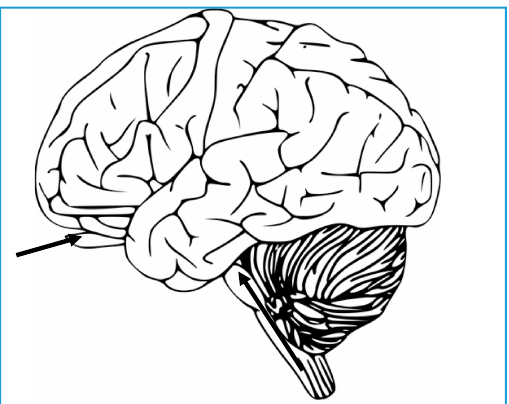
Figure 4. Schematic of brain with arrows depicting origins of the brain pathology—i.e., brain stem and olfactory bulb in Parkinson’s disease based on extensive autopsies. Corresponding routes allow ultrafine particle air pollution to enter the brain while bypassing the blood brain barrier.